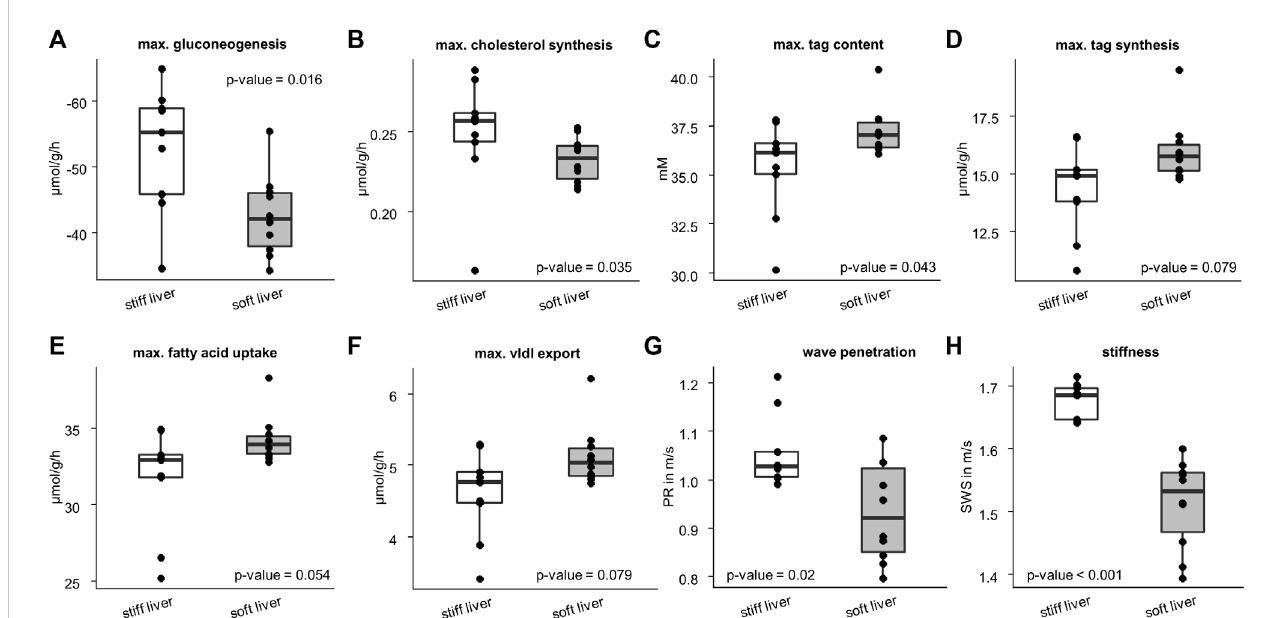
FIGURE 6 Differences in metabolic capacities and imaging parameters between the soft and stiff livers. Stiff group consist of 10 samples and soft group of 9samples.Metaboliccharacteristics: (A) gluconeogenesis; (B) cholesterolsynthesis; (C) triacylglycerol(tag)content; (D) tagsynthesis; (E) fattyaciduptake; (F) verylowdensity lipoprotein(vldl)export.Imagingparameters: (G) wavepenetration(PR); (H) shearwavespeed(SWS).Corresponding p -valuesbasedontwo- sided t -test or Wilcoxon signed-rank test are given. The center line represents the median, the box represents the interquartile range, and the whiskers are de fi ned by values within 1.5 times the interquartile range. Outliers are represented as dots.